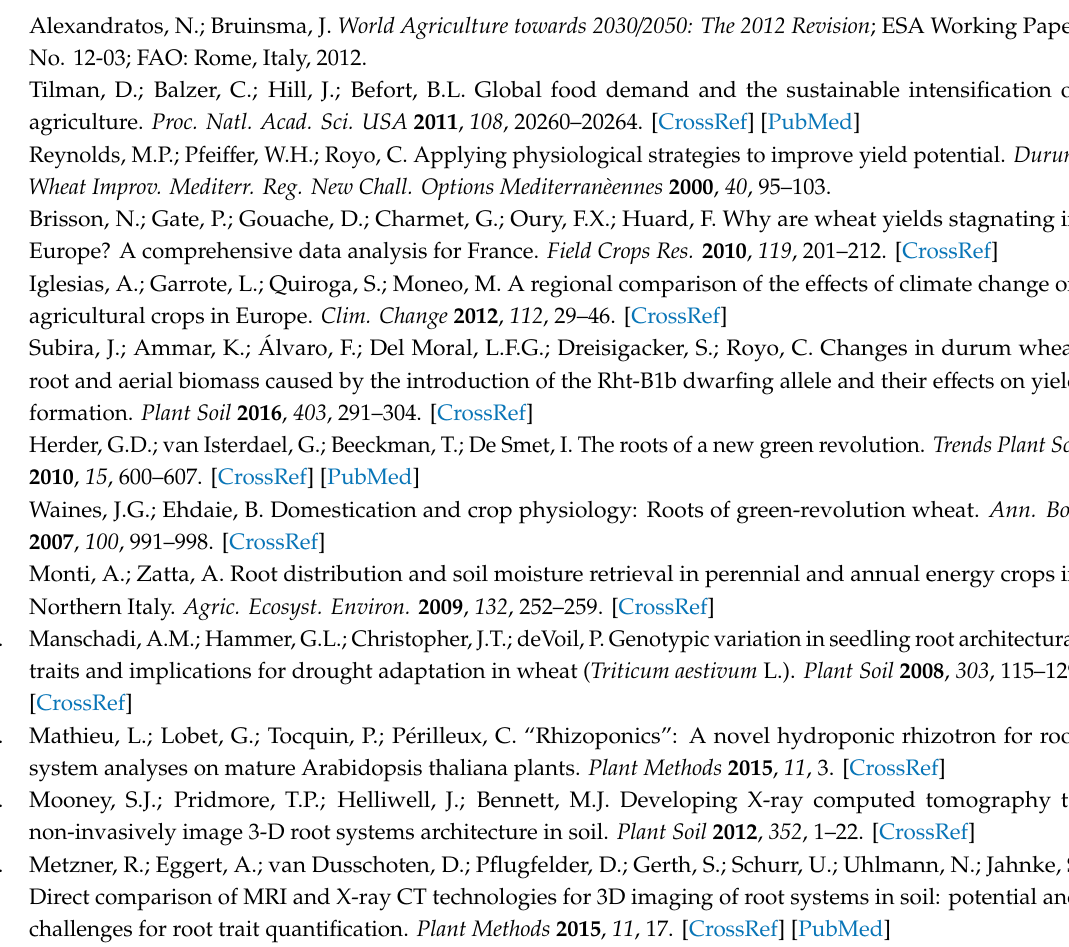
exhibit a deep rooting profile pattern, optimal conditions peaking at 17.35 mm cm − 2 at anthesis (out of figure). Figure S4. E ff ect of the Irrigation, Nitrogen (I, N) treatments on the dynamic of the Nogal synthetic wheat root length surface density profiles (mm cm − 2 ) estimated from minirhizotron at di ff erent stages. Mean root length surface density profiles of the Nogal synthetic wheat cultivar are shown at tillering (Z25), stem elongations (Z30), flag leaf ligule (Z39) and anthesis (Z65) stages. Optimal and stressful conditions show contrasted rooting pattern. Under optimal conditions, this synthetic wheat cultivar exhibits a deep root profile, as measured for the bread wheat Apache cultivar. On the opposite, under stressful conditions, the root pattern developed is closer to the durum wheat Miradoux cultivar. Figure S5. Comparison of the root length surface density profiles obtained with minirhizotron technique at anthesis half-way (Z65) on average for each wheat cultivar under stressful conditions (I – N − ). Similarities are found between the rooting profiles of Apache and Hystar cultivars on the one hand, and Miradoux and Nogal cultivars on the other hand. A parallel may be drawn regarding their grain yield in this I − N − treatment: higher yields being obtained by Apache and Hystar cultivars (7.17 t ha − 1 , 7.65 t ha − 1 , respectively) and lower yields obtained by Miradoux and Nogal cultivars (5.79 t ha − 1 , 6.06 t ha − 1 ,